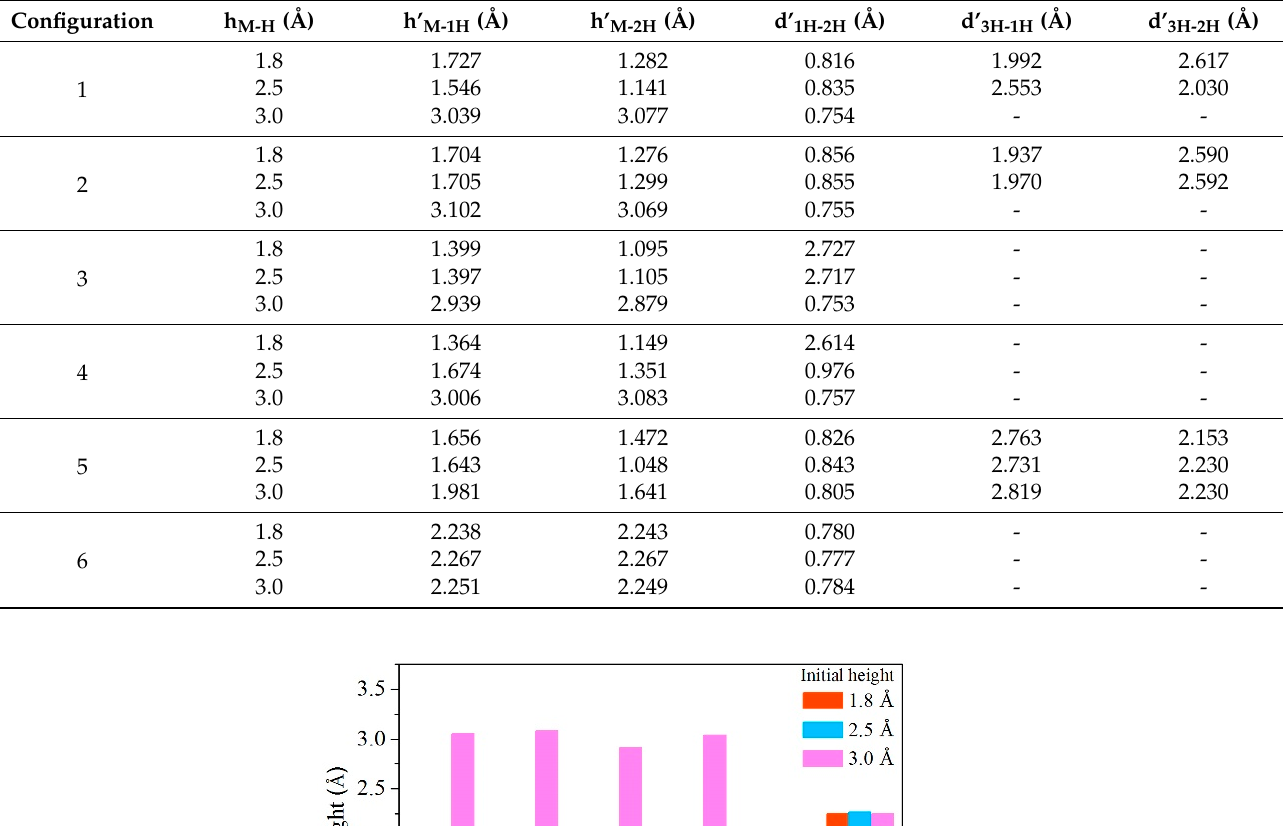
Table 1. Structural parameters for the molecular hydrogen desorption on TiZrVMoNb hydride (110) surface with different initial heights (hM-H) of 1.8, 2.5 and 3.0 Å in the six configurations as shown in Figure 2. Here, hM-H refers to: the vertical distance between the H2 molecule and the nearest-neighboring metal atom on surface before optimization; h’M-1H and h’M-2H: the vertical distance between each atom of the H2 molecule and the nearest-neighboring metal atom on surface after optimization; d’1H-2H: the distance between the two H atoms of the H2 molecule after optimization; d’3H-1H and d’3H-2H: the distance between each atom of the H2 molecule and the third hydrogen atom dissociated from the TiZrVMoNb hydride (110) surface, as shown in Figure 5.